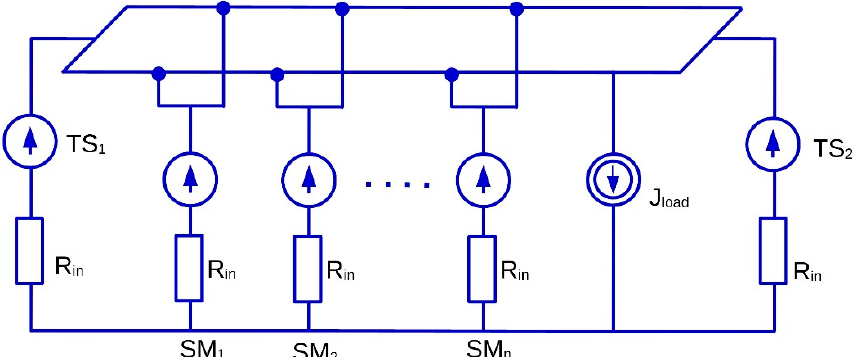
Figure 3. The equivalent instantaneous scheme of the proposed distribution supply system used in the simulation model of the system.